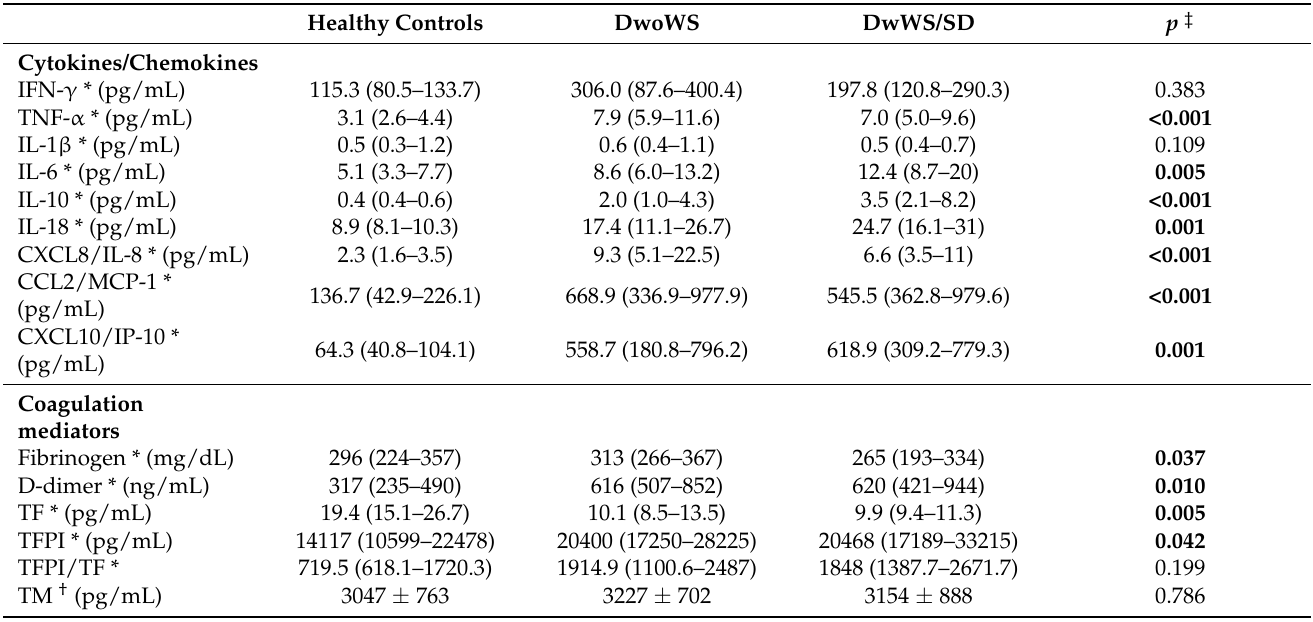
Table 2. Cytokines, chemokines and coagulation mediators in healthy controls and confirmed cases of dengue according to WHO 2009